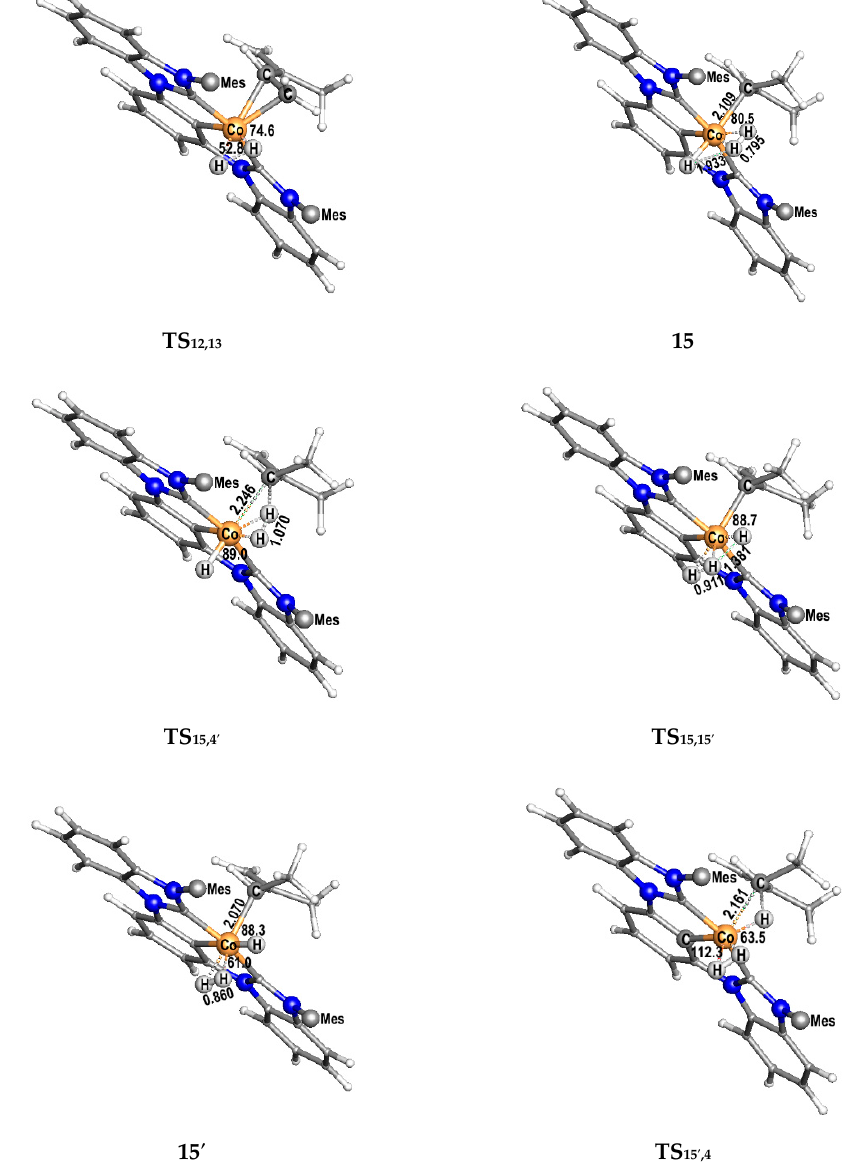
Figure 6. Optimized structures of TS 12,13 (722 i cm − 1 ), 15 , TS 15,4 ′ (1148 i cm − 1 ), TS 15,15 ′ (340 i cm − 1 ), 15 ′ , and TS 15 ′ ,4 (932 i cm − 1 ). Mesitylene groups are omitted for clarity. Bond lengths are in Å, and bond angles are in °.